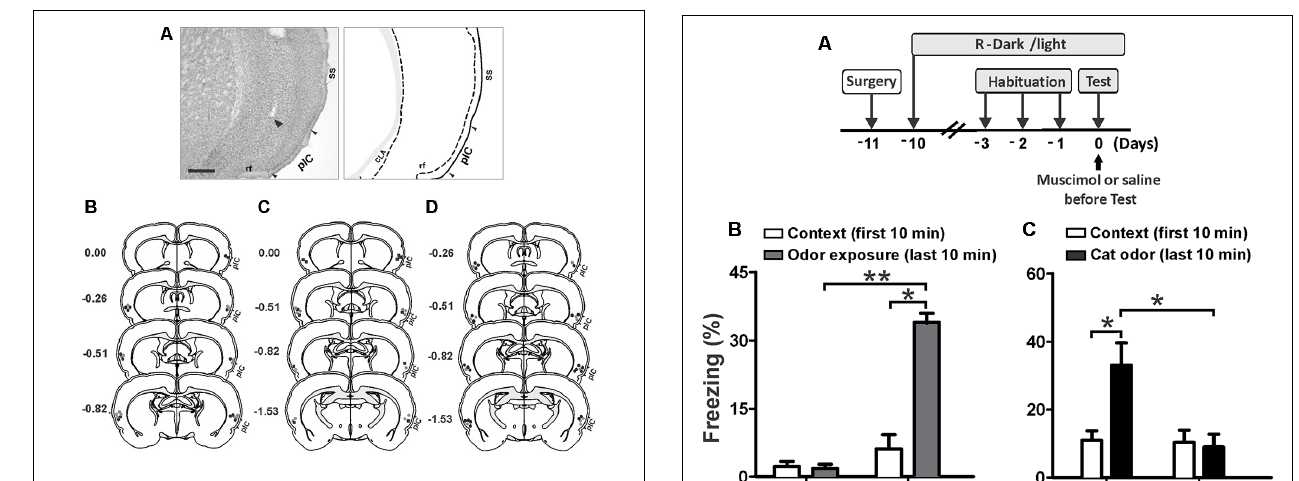
FIGURE 1 | Histological analysis. (A) Photomicrograph of a Nissl-stained coronal section (left panel) showing the tip of the injection cannula track (arrowhead) in the primary interoceptive cortex (pIC) and a corresponding schematic drawing (right panel). (B–D) Reconstructions of the different injection sites of saline (gray circles), muscimol (black circles) and NSTX (black squares) into the pIC. (B) Experiment 1. (C) Experiment 2. (D) Experiment 3. Scale bar, 500 µ m. Abbreviations: CLA, claustrum; rf, rhinal fissure; SS, somatosensory cortex.